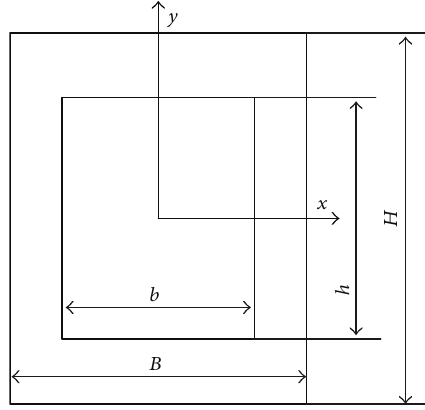
Figure 5: Boom cross section parameters.